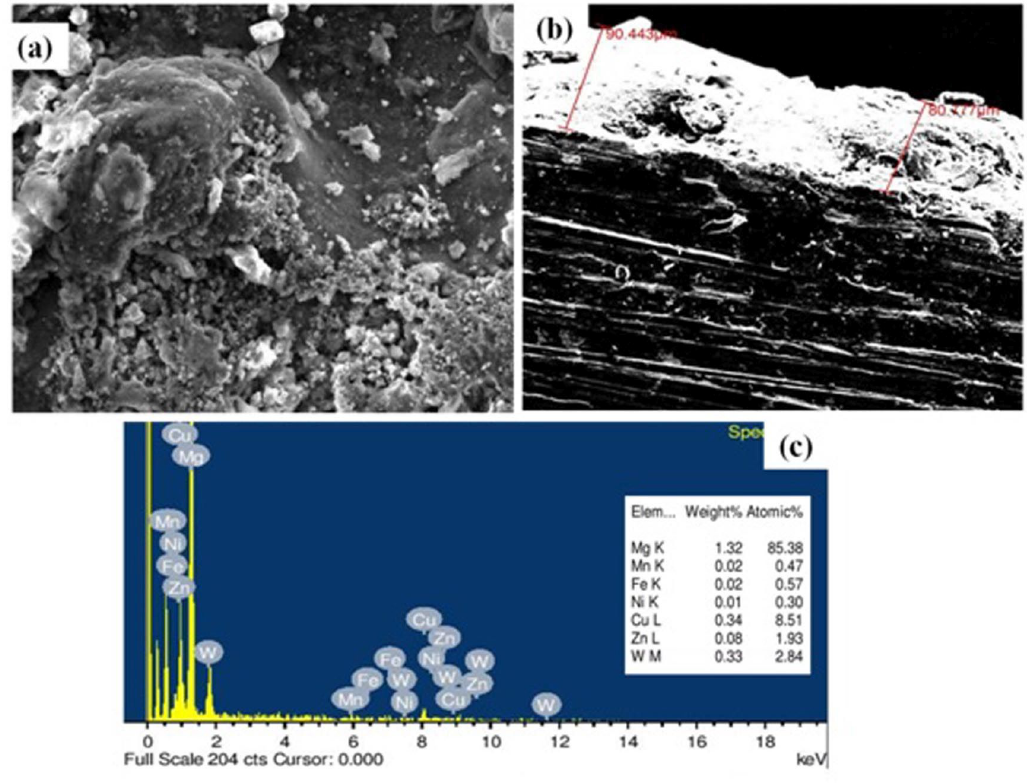
Figure 2: (a) SEM image of bulk deposition at 150 MPa, 4A, 90 µ s; (b) deposited layer thickness; (c) EDS peak